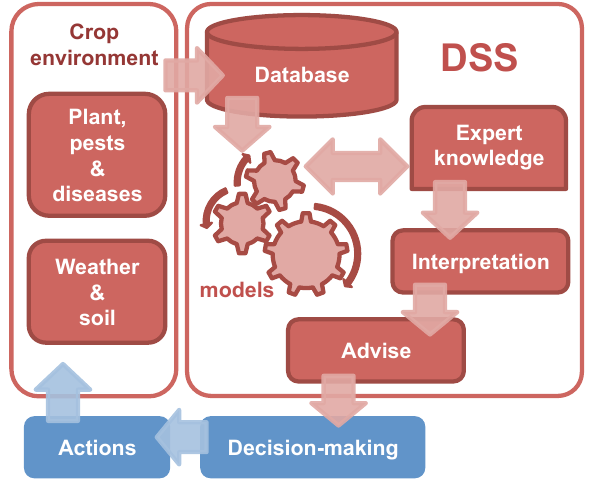
Figure 10. Scheme of an innovative Decision Support Sys - tem (DSS) for plant disease management. The information flows to and from the environment in an endless loop that begins with sensing and ends with action. Models are the key component of the DSS. The DSS provides information and guidance to the user but the user makes the decisions.